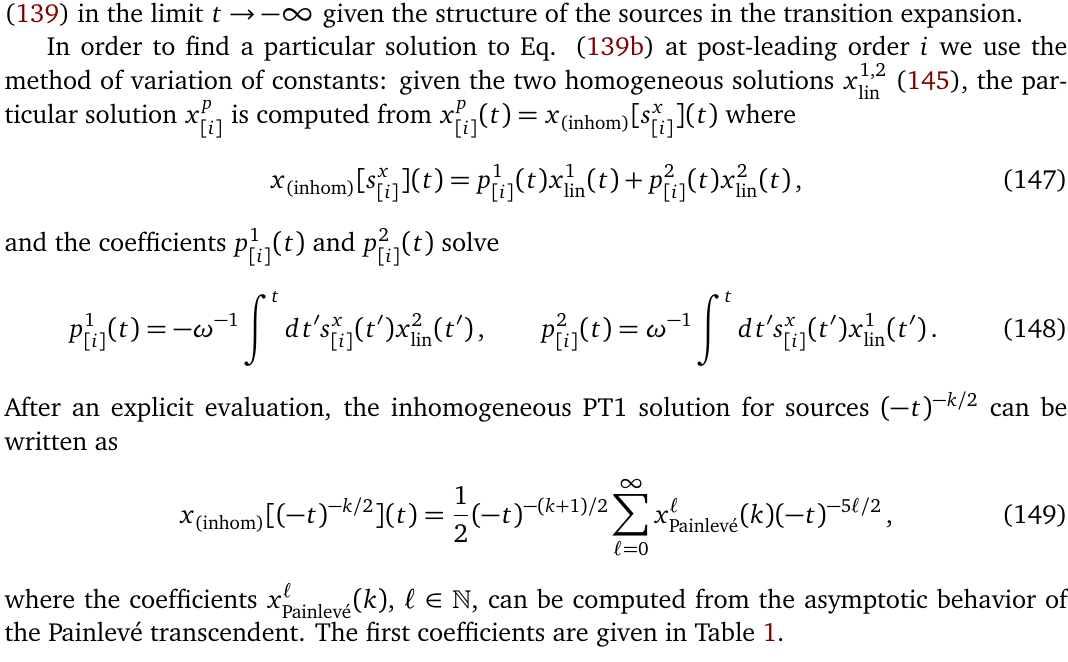
Table 1: Coefficients of the inhomogeneous solution to the Painlevé PT1 equations for a source ( − t ) k / 2